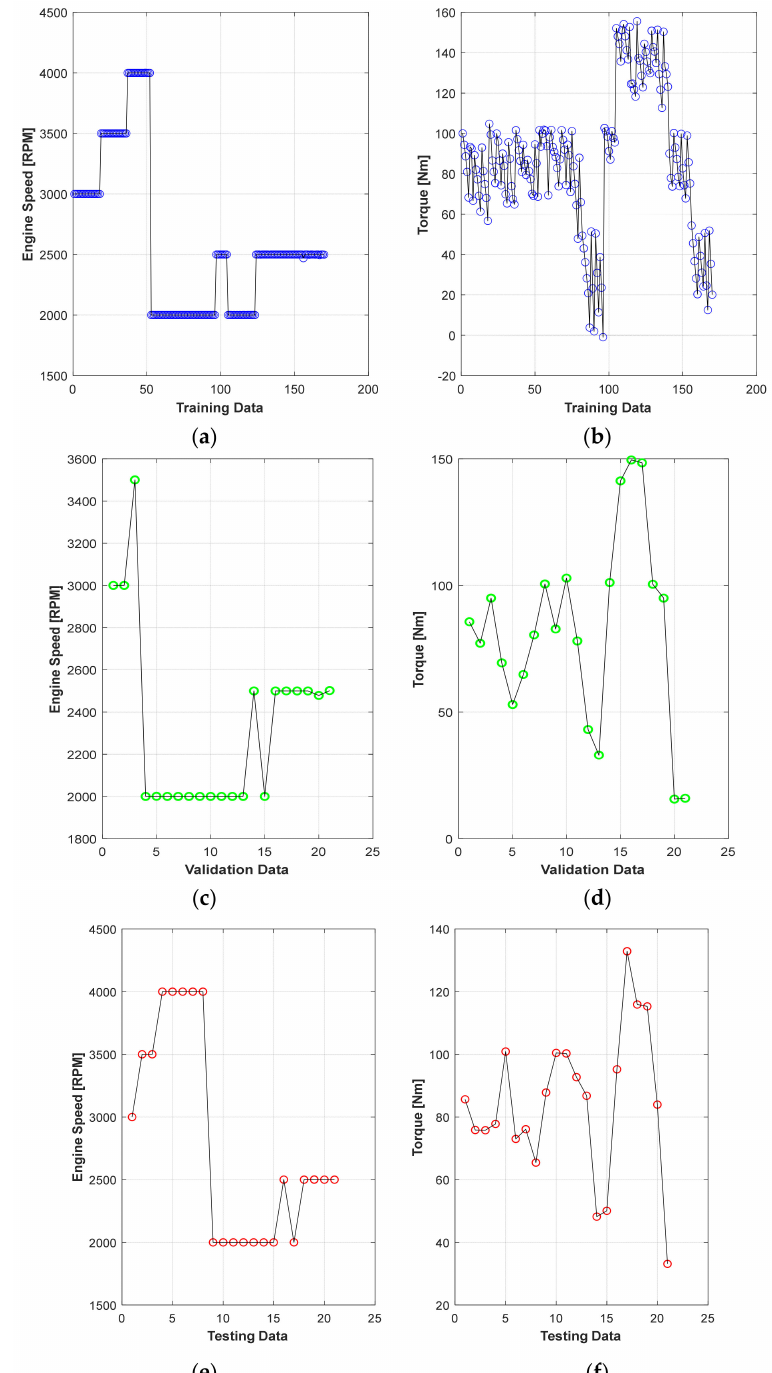
Figure 5. This figure shows the engine speed and torque classification of the data used for the CA50 ANN model’s development: ( a ) engine speed training data; ( b ) torque training data; ( c ) engine speed validation data; ( d ) torque validation data; ( e ) engine speed testing data; ( f ) torque testing